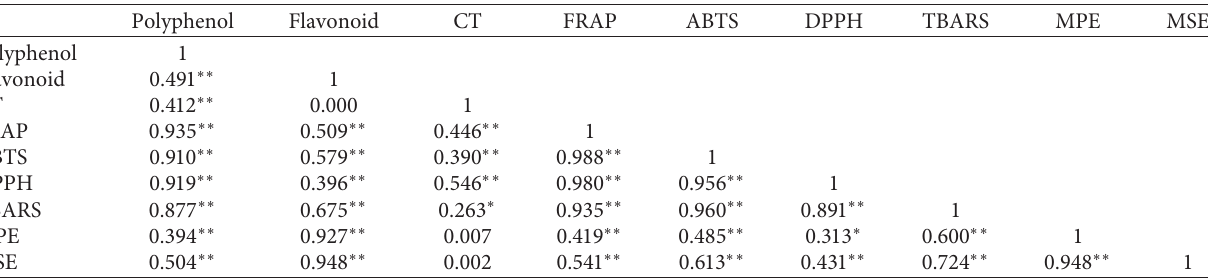
Table 5: Correlation between polyphenols, flavonoids, condensed tannins, antioxidant, antiperoxidative, and antihemolytic